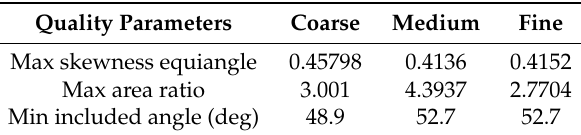
Table 4. Quality parameters of the